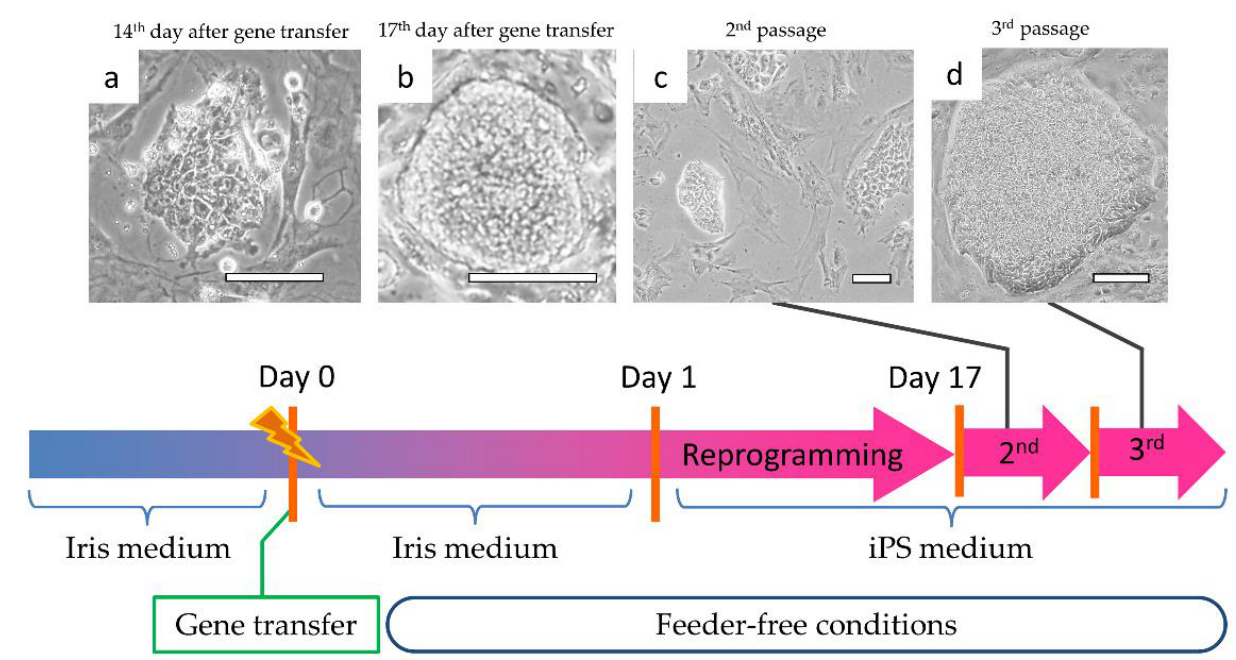
Figure 2. Reprogramming process of H-iris iPS cells. Cell morphology at the ( a ) 14th day of gene transfer; ( b ) 17th day of transfer; ( c ) second passage; ( d ) third passage. Bars: 100 μm.